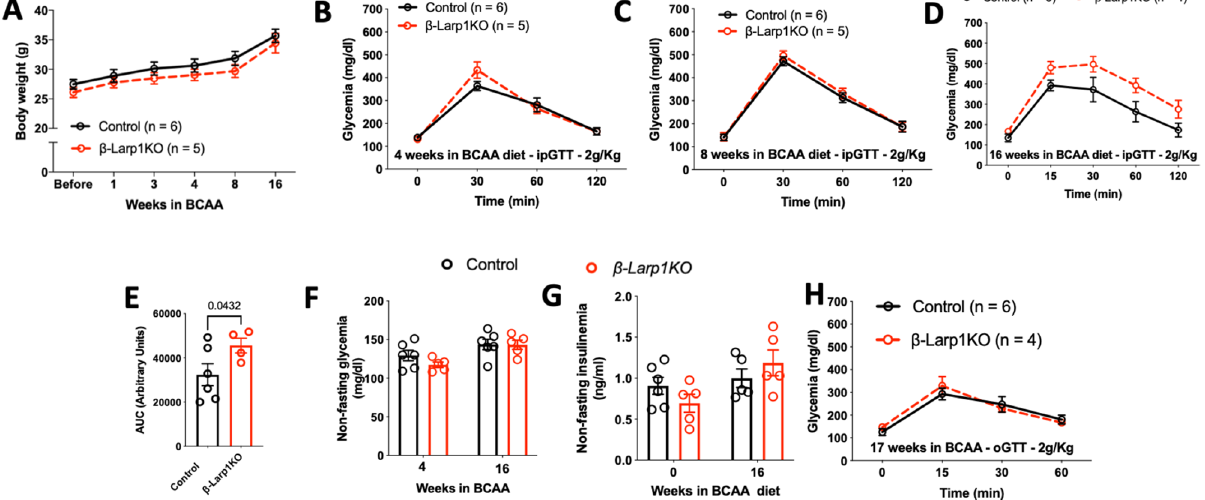
Figure 8. β-Larp1KO mice under high branched-chain amino acid diet (BCAA). ( A ) Body weight of mice fed with high branched-chain amino acid diet (150% BCAA) for 16 weeks. Intraperitoneal glucose tolerance test (ipGTT) after 4 ( B ), 8 ( C ) and 16 ( D ) weeks in BCAA diet. ( E ) Area under the curve in the ipGTT performed in D . P value compared to control mice assessed by Student’s T test. Non-fasting glycemia ( F ) and insulinemia ( G ). ( H ) Oral glucose tolerance test (oGTT) after 17 weeks in BCAA